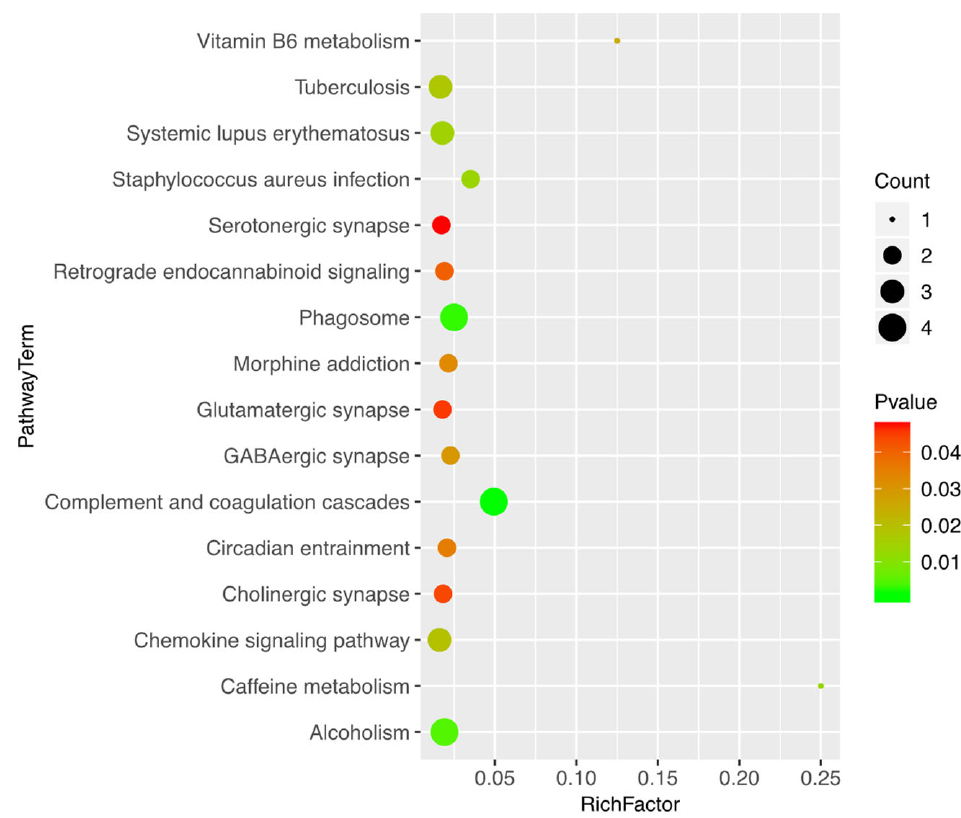
Figure 3. KEGG pathway analysis of the differentially expressed proteins.